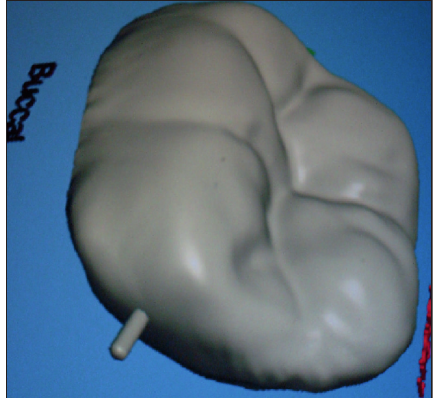
Figure 1: Postobturation occlusal view showing the amount of residual tooth structure.